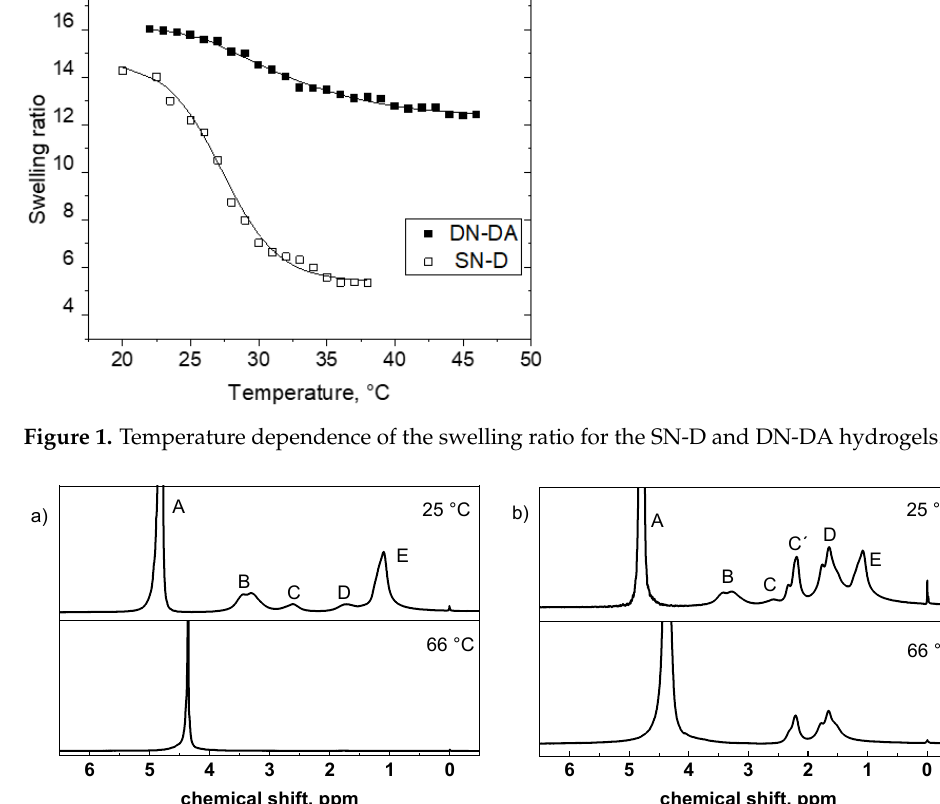
Figure 2. The 500.1 MHz 1 H spectra of the hydrogels ( a ) SN-D and ( b ) DN-DA in D 2 O recorded at 25 °C and 66 °C under the same instrumental conditions. Peak assignments are explained in the text and in Scheme 1.